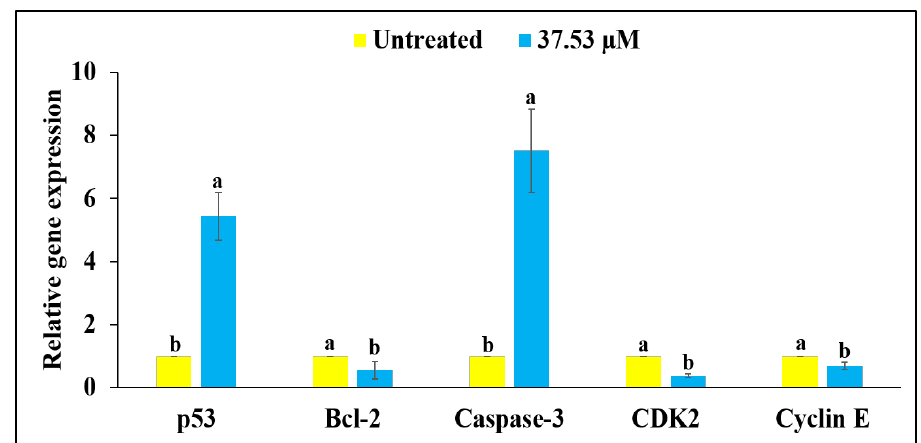
Figure 14. Effect of BDCe fraction from O. bracteata on the gene expression for p53, Bcl-2, Caspase- 3, CDK2 and Cyclin E genes in MG-63 cells as detected using RT-PCR. Values are expressed as mean ± SE. Data labels with different letters represent significant differences among them at ( p ≤ 0.05).